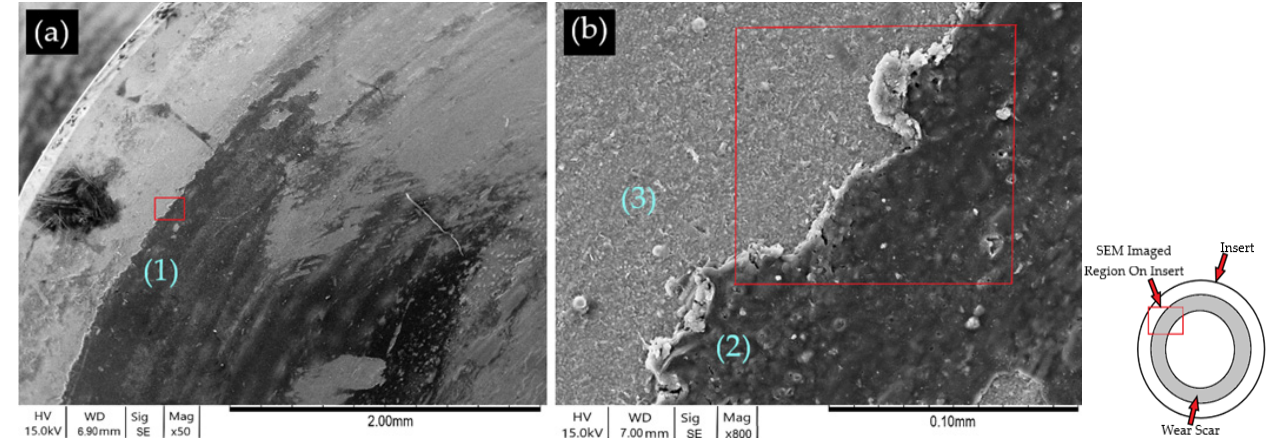
Figure 9. SEM images of Coating B after pin-on-disc Test 1b: ( a ) ×1500 magnification, ( b ) ×3000 mag- nification. This type of deformation correlated into a controlled and effective dispersion of the applied loads between the steel ball counter specimen and Coating B. The high stability characteristics and low coefficient of friction of the TiN outer layer, together with the higher stability and robustness of the amorphous α -Al 2 O 3 interfacial layer of Coating B compared to Coating A, created a coating microstructure that was equipped to resist and distribute the high loads being applied. M’Saoubi et al. [15] conclude that a textured α -Al 2 O 3 microstructure that has a con- trolled crystal orientation has a high resistance to deformation, as can be seen in Figures 8 and 9. The textured microstructure exhibits very high stability when subjected to high load forces at ambient temperatures. For Test 2a and Test 2b (Figures 10–13), linear velocity in the test fixture was reduced to 1.0 m/s when compared to the linear velocity of 2.0 m/s that was utilised in Test 1a and Test 1b for Coating A and Coating B. The reduction in linear velocity was undertaken to investigate if this would have an impact on the sliding distance that could be attained before failure and the wear charac- teristics that had been evident in Test 1a and Test 1b for both Coating A and Coating B. The friction coefficient for Coating A, as seen in Figure 3b, remained near constant until